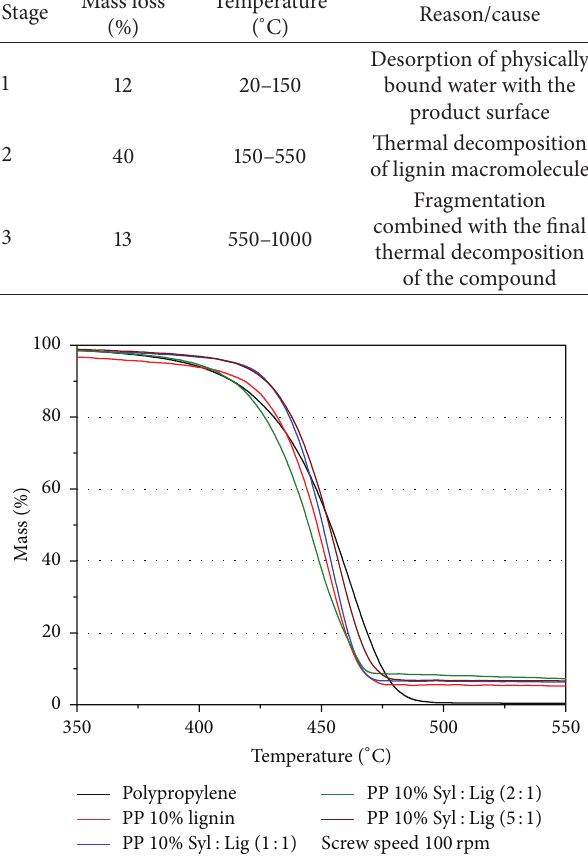
Figure 4: Thermal degradation curves versus temperature for pure PP and its blends with lignin and hybrid fillers, after extrusion with 100 rpm of screw